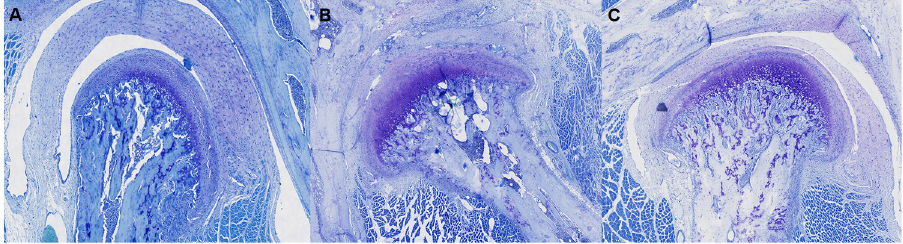
Fig 3. Examples of histological slides after toluidine blue staining. A: sample (before injection of MIA or Col-2) without histological and staining modification; B: sample (day 30 Col-2) with a pannus, hypocellularity, and moderate staining reduction; C: sample (day 30 MIA) with hypocellularity, clefts, and severe reduction of proteoglycan staining.